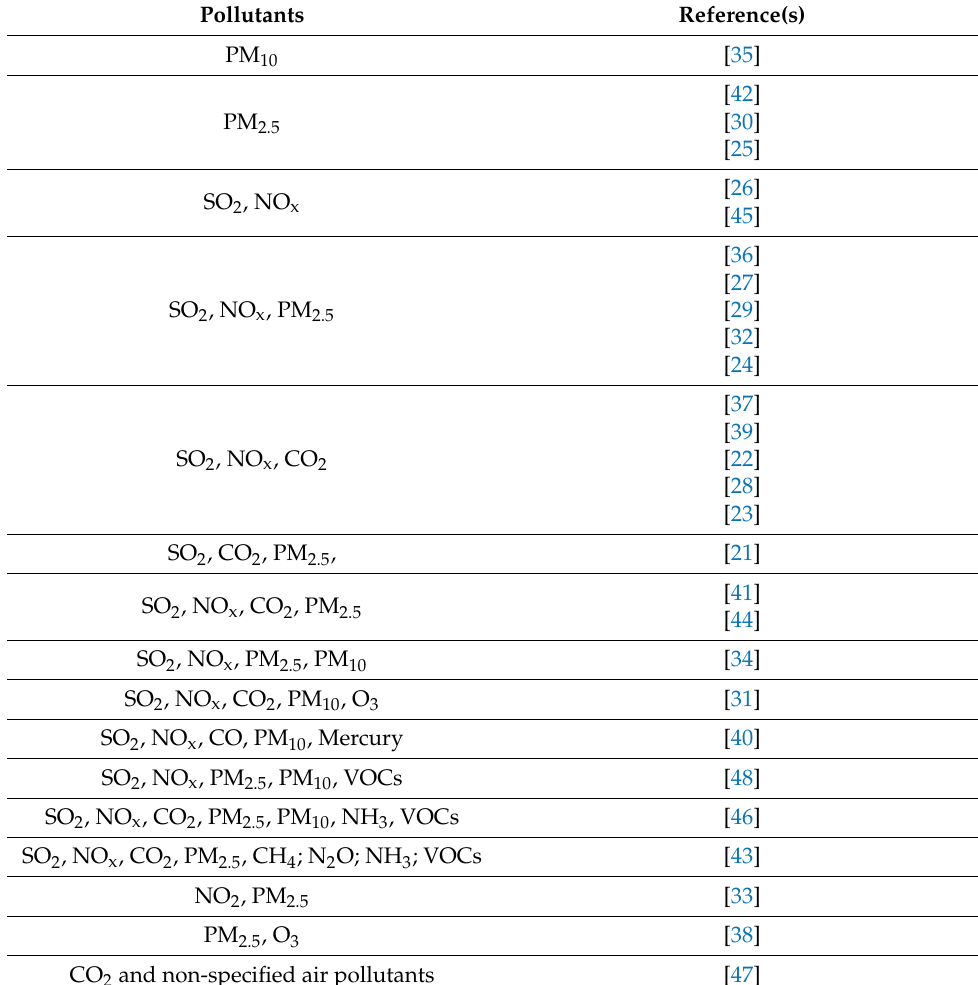
Table 7. Types of pollutants included in the literature (source: own